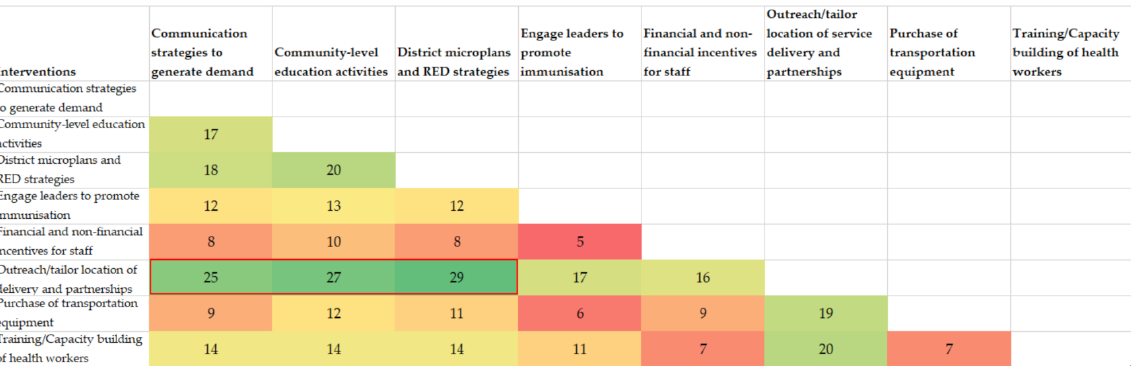
Figure 2. Correlation matrix representing the number of times the eight most common intervention categories were planned with each other in HSS